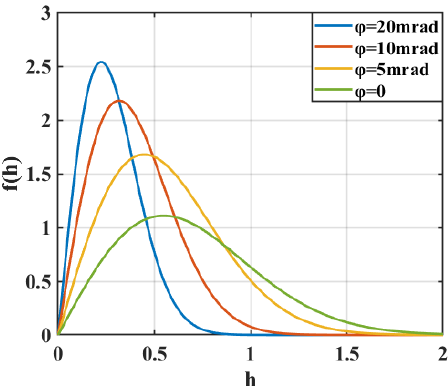
Figure 4. Normalized distribution of the channel coefficient at different tilt angles when the UAV flies straight at the same altitude.